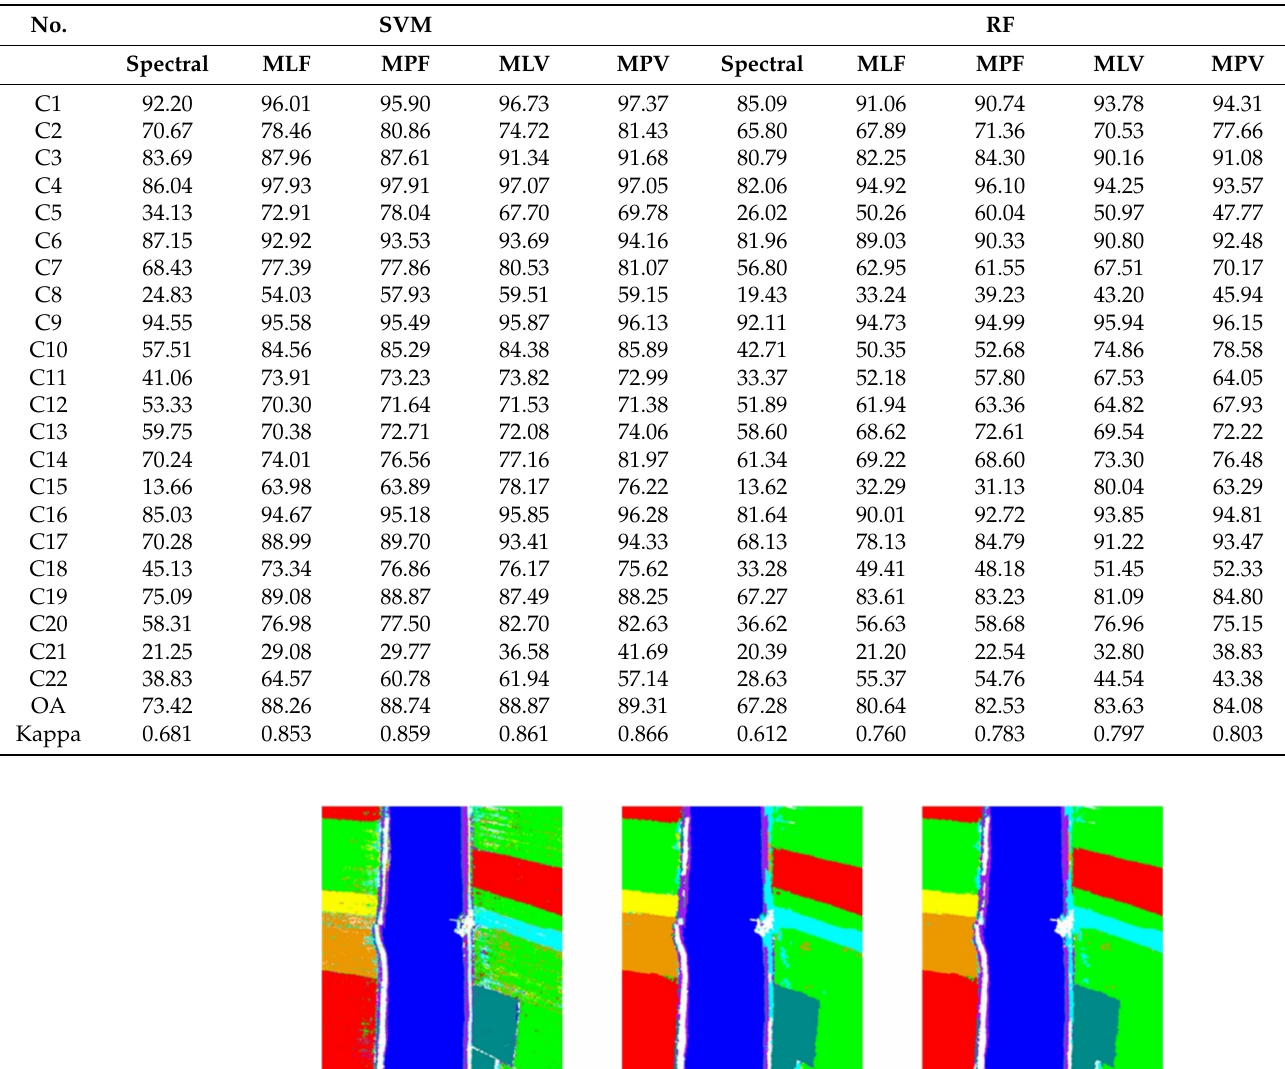
Table 12. Classification accuracies given by different methods for the Honghu dataset using SVM and RF with 100 training samples per class.